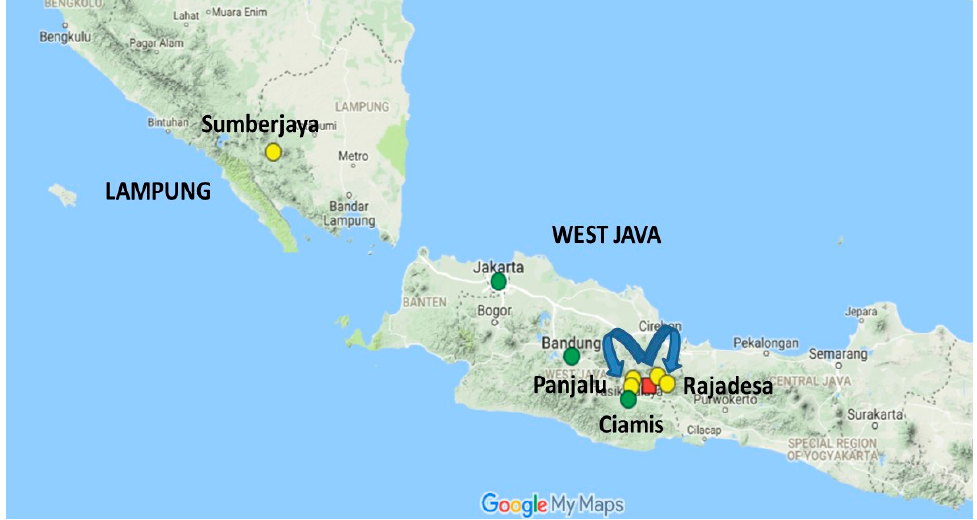
Figure 3. The source (right) and destination (left) of migrants in our second case study, West Java and Lampung.